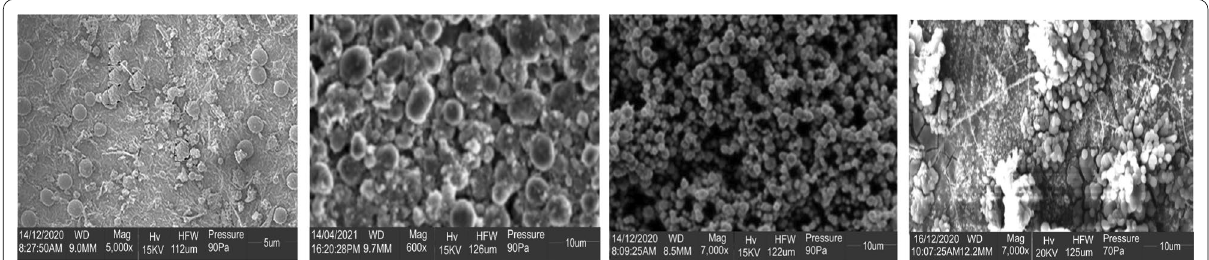
Fig. 2 Scanning electron microscopy images of stable curcumin‑loaded liposomes, size range from 5 to 10 µm